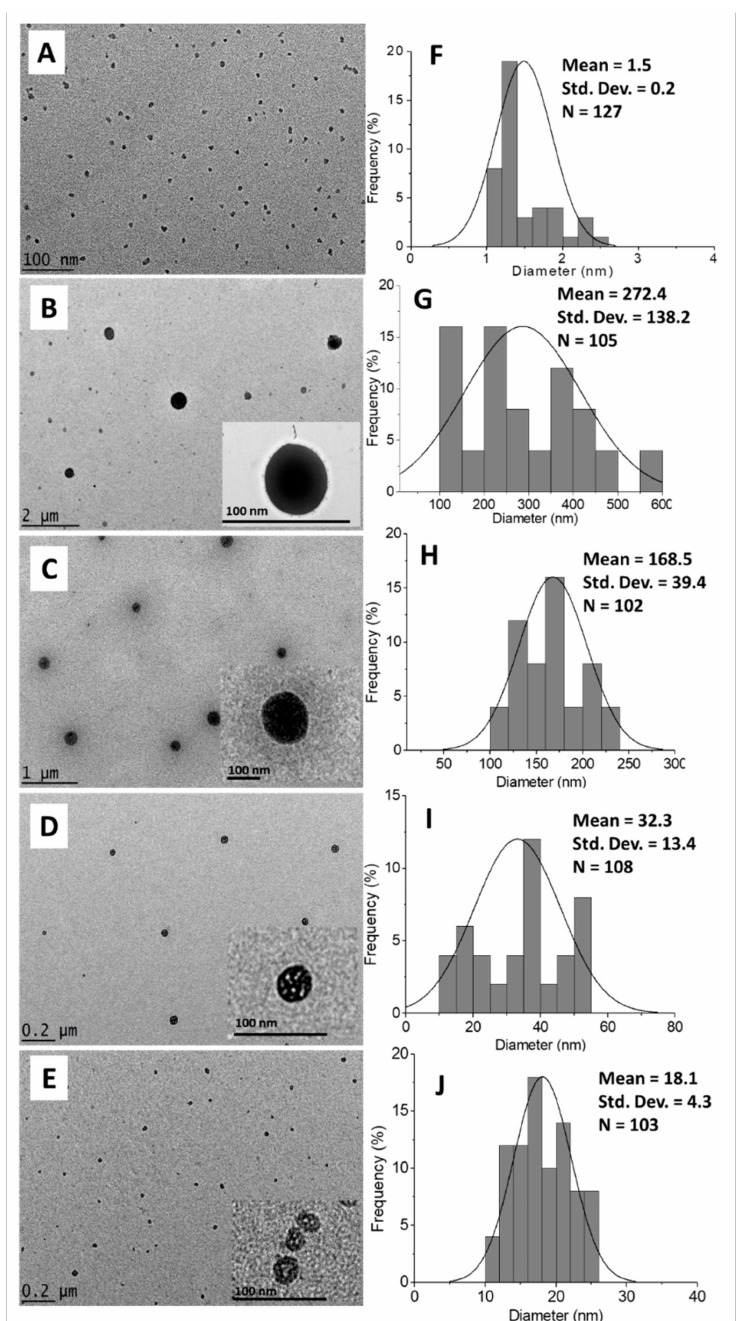
Figure 4. HRTEM image of ( A ) CEN and chitosan–hexaconazole nanoparticles prepared at various concentrations of TPP, ( B ) 2.5, ( C ) 5, ( D ) 10, and ( E ) 20 mg / mL and their particle size distribution of ( F ) CEN and chitosan–hexaconazole nanoparticles prepared at various concentrations of TPP, ( G ) 2.5, ( H ) 5, ( I ) 10, and ( J ) 20 mg /